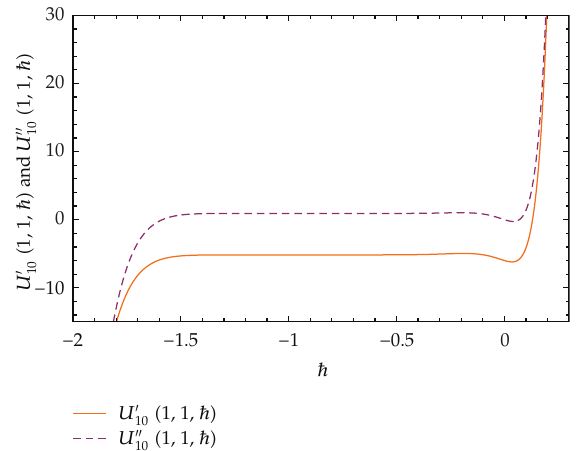
Figure 3: The ℎ curves of 𝑈 󸀠 10 (1,1, ℎ) and 𝑈 󸀠󸀠 10 (1, 1, ℎ) for C - S